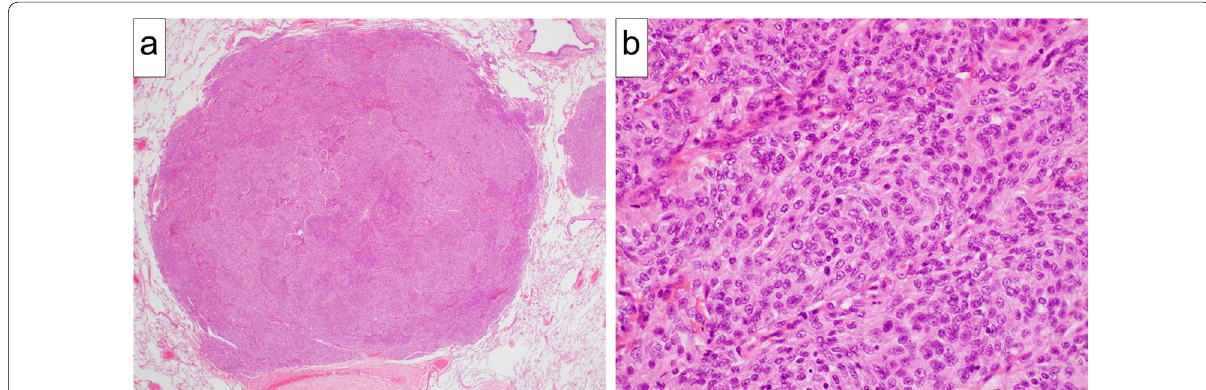
Fig. 3 Pathological findings of the pulmonary metastasis of meningioma. a The boundary between the tumor and surrounding tissue was clear (hematoxylin–eosin staining, original magnification 20 ). b Short spindle-shaped tumor cells with a slightly acidophilic cytoplasm and exhibiting × complex proliferation were detected (hematoxylin–eosin staining, original magnification